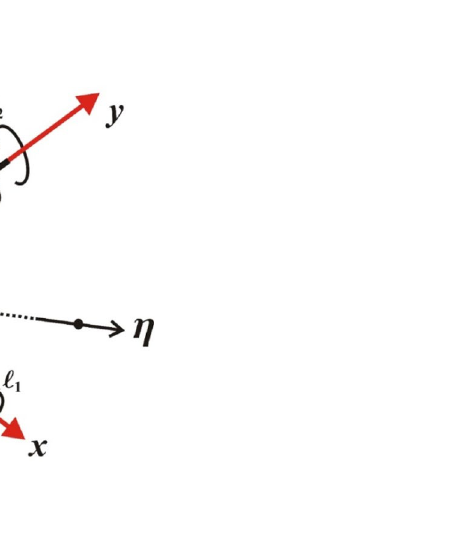
Figure 2. Portrays the motion of the